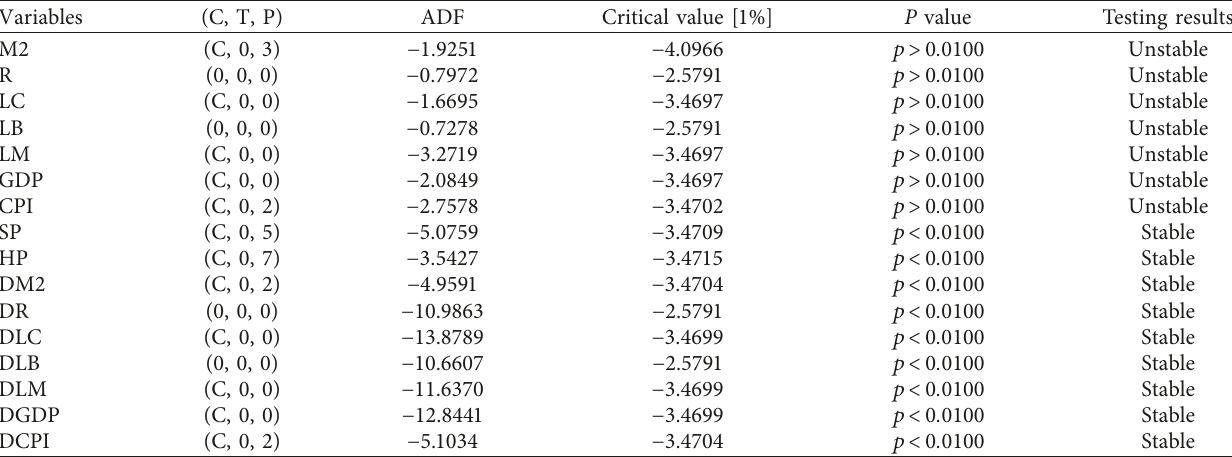
Table 2: Unit root ADF test.